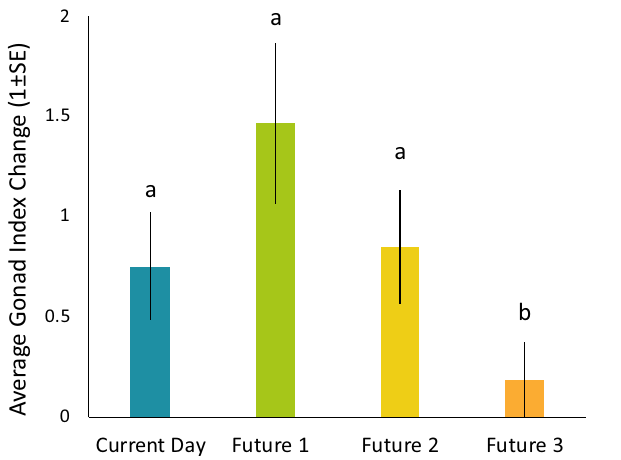
Figure 4. Average (1 ± SE) gonad index change for kelp forest urchins in each of the four upwelling severity